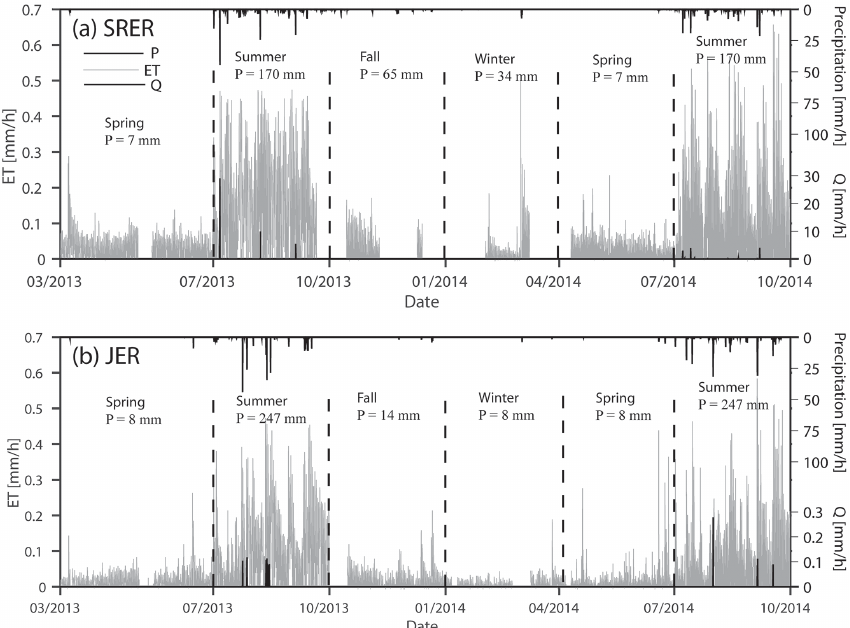
Figure 3. Hourly precipitation, streamflow, and evapotranspiration at the (a) SRER and (b) JER sites during the study period (March 2013 to September 2014). Gaps in ET data indicate periods of EC tower malfunction due to equipment failures, data collection problems, or vandalism. Vertical dashed lines indicate the seasonal definitions and their corresponding total